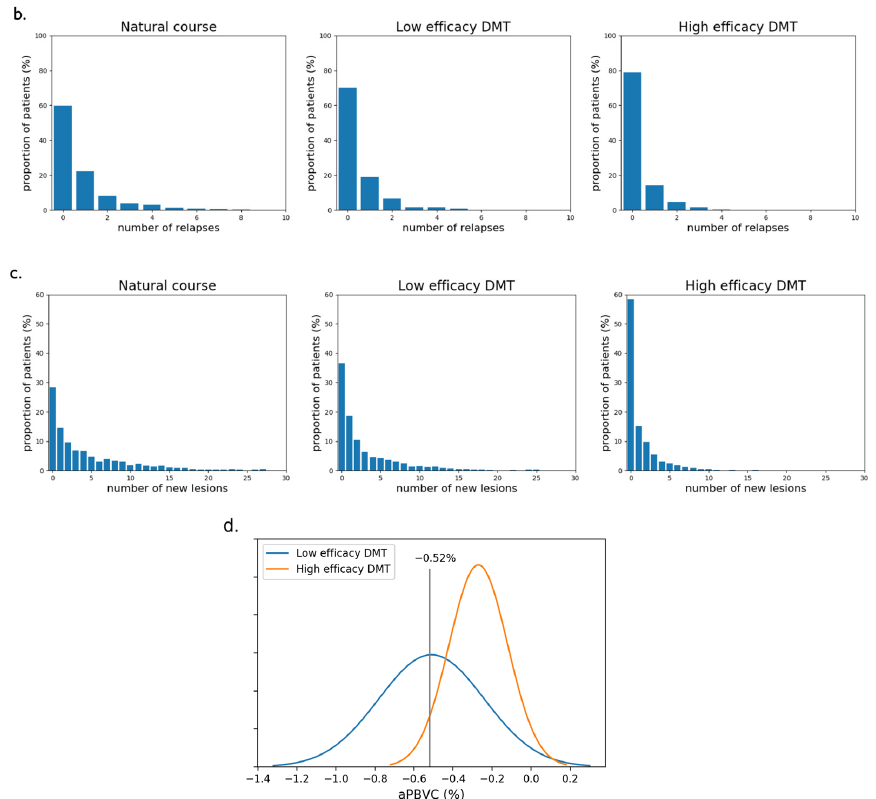
Figure A1. Distribution of simulated disease activity parameters. For comparison purposes, we show the untreated MS (natural course) distributions, together with those modulated by low or high efficacy DMTs. Efficacy rates are randomly generated to be representative for a whole family of DMTs, as specified in Table 2, and are thus not specific for a single DMT. ( a ) EDSS transitions showing the proportion of patients moving to the next EDSS state at the end of a cycle, when the EDSS at the beginning of the cycle was 0, 1, 2, or 3; ( b ) histograms of the number of relapses during one cycle, assuming an EDSS of 1; ( c ) histograms of the number of new lesions during one cycle; ( d ) Gaussian distributions of aPBVC for healthy controls, which is also used as target distribution for high efficacy DMT, and (untreated or on low efficacy DMT) MS patients. The − 0.52% threshold giving 5% ‘false positives’ is illustrated (from [22]). With a mean of the MS distribution at − 0.51%, the ‘sensitivity’ for this threshold is 49%. Table A7. The proportion of simulated patients where disease activity would be detected based on individual criteria is presented in Table 1, with different threshold choices.